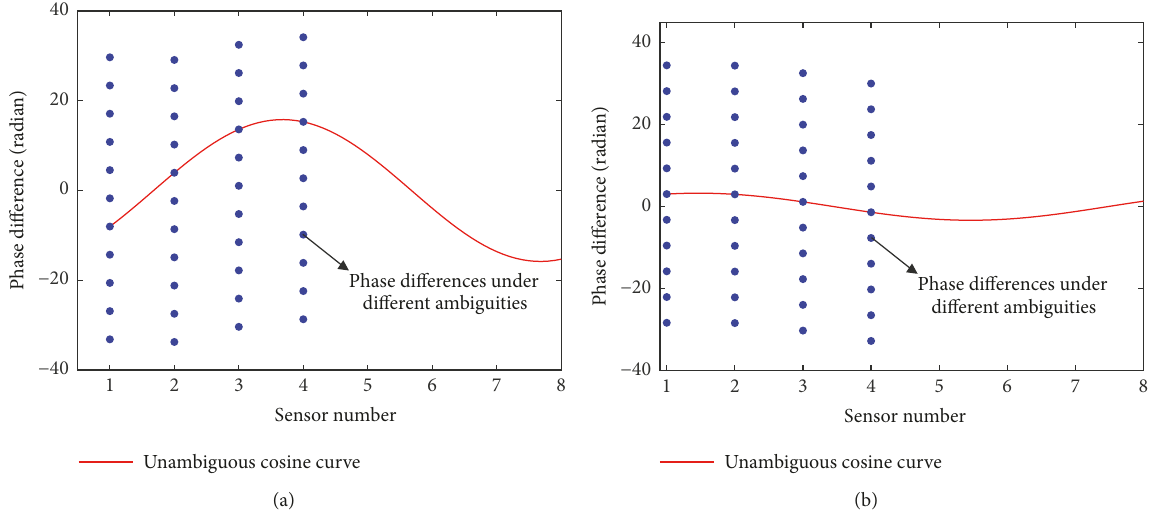
Figure 6: Phase differences under different ambiguities. (a) Source 1. (b) Source